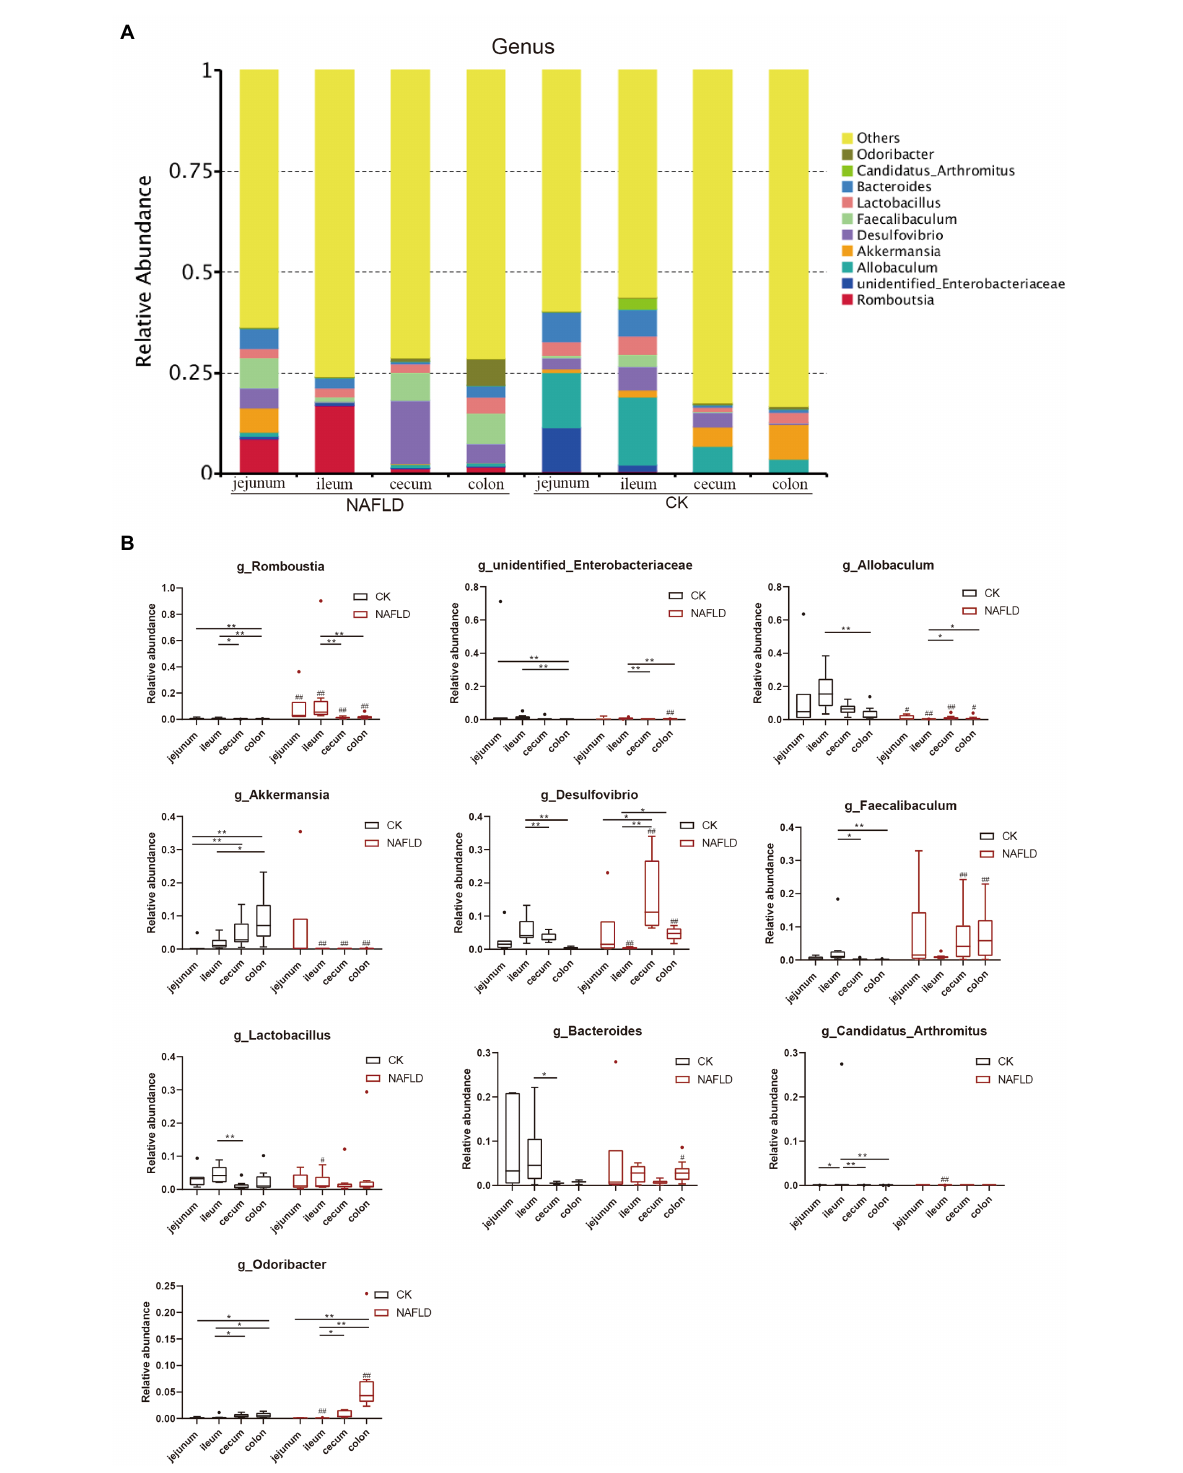
FIGURE 8 Relative abundance of bacteria at genus level. (A) Stacked column graph of the top 10 genera with the highest relative abundance. (B) The box diagram was used to analyze the differences in relative abundance of the five genera with the highest relative abundance. Wilcox Rank-sum test was used to compare the significance of the same intestinal segment between the CK group and the NAFLD group; Kruskal-wallis test was used to compare the differences between different intestinal segments in the same group. *indicate significant difference in the different intestinal segments in the CK group and NAFLD group. # indicates the significant difference in the same intestinal segments between CK group and NAFLD group. *or # p < 0.05; **or ## p <